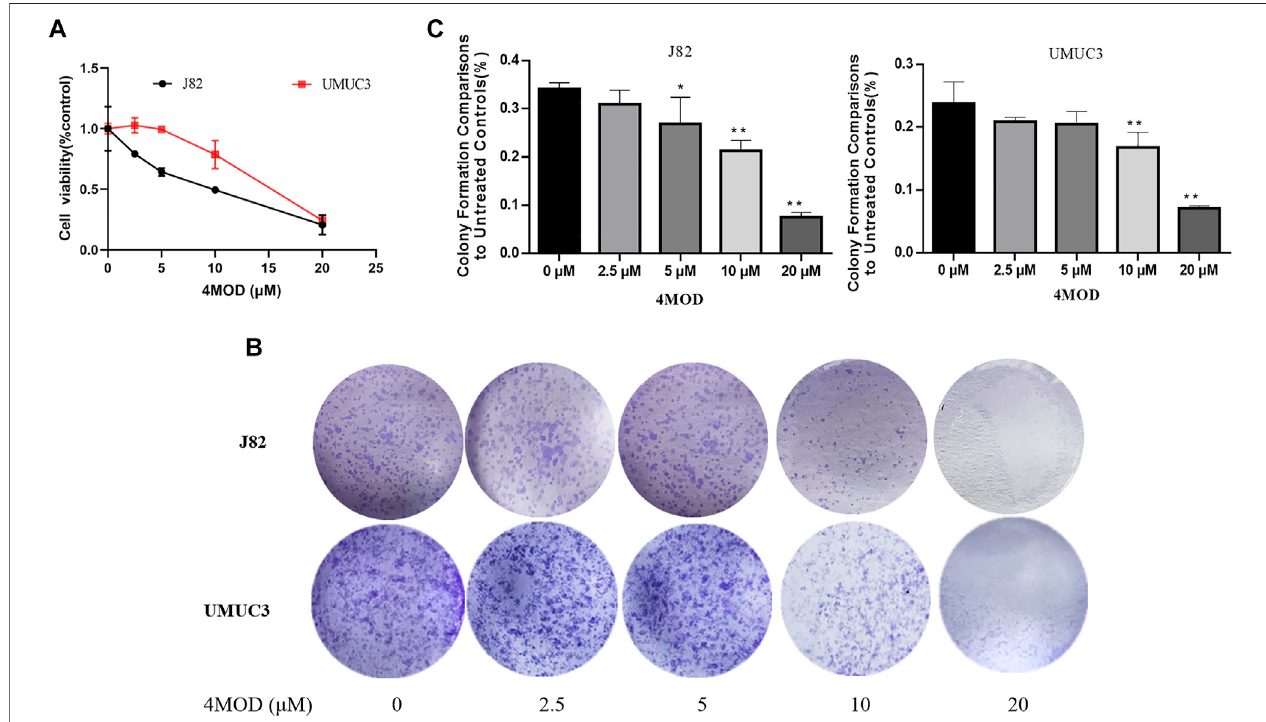
FIGURE 1 | 4MOD inhibits the proliferation of BC cells (A) CCK8 assay on the human BC cell lines UMUC3 and J82 treated with 4MOD at concentrations ranging from 0 to 20 μ M or DMSO for 72 h. (B) The clonogenic assay assessed after 7-days of 4MOD treatment at various concentrations (0 – 20 μ M) (C) Bar chart shows quantitative data of average of 3 independent experiments (* p < 0.05, ** p < 0.01 compared with control). Quantitative data determined by solubilization of crystal violet and spectrophotometric reading at OD 550 nm. Results are presented as mean ± SD of 3 independent experiments (Comparison was drawn by the t -test (two- tailed). Data represent means ± SD; * p < 0.05, ** < 0.01).